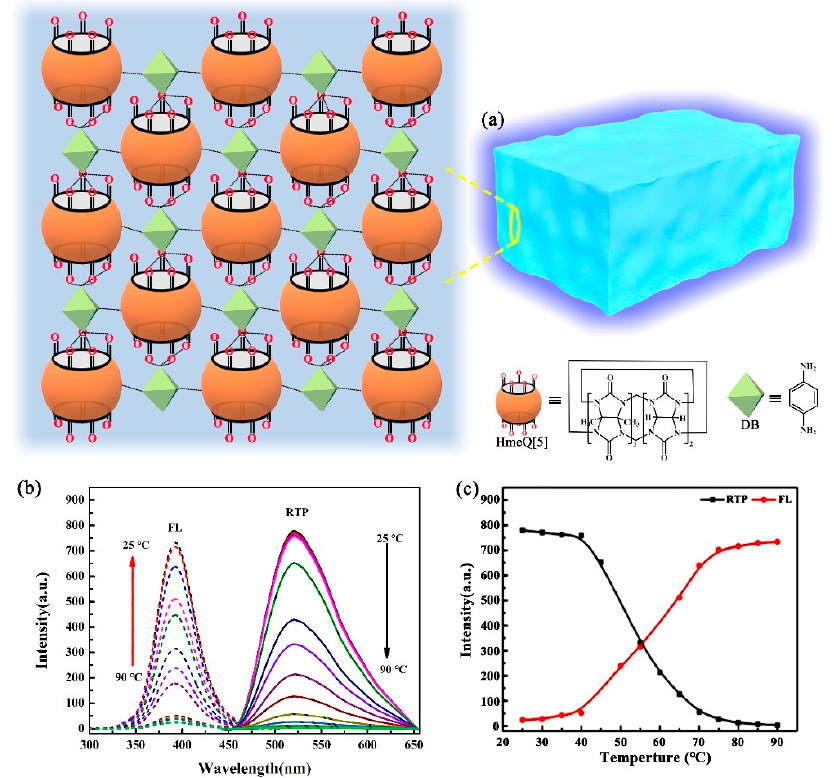
Figure 6. ( a ) HmeQ[5]/p-PDA supramolecular hydrogels by the host–guest exclusion interaction; ( b ) fluorescence and phosphorescence spectra at different temperatures; ( c ) variation in fluorescence and phosphorescence intensity versus temperature.